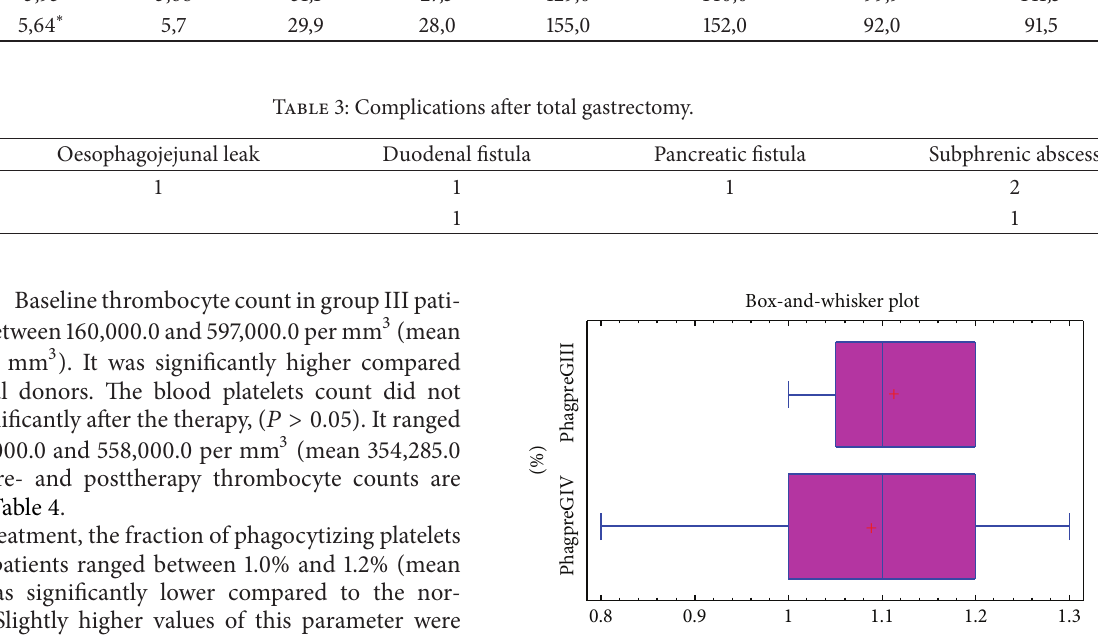
Figure 1: Values of phagocytizing platelets in patients of group III (%phagpreGIII) and group IV (%phagpreGIV) patients determined before the